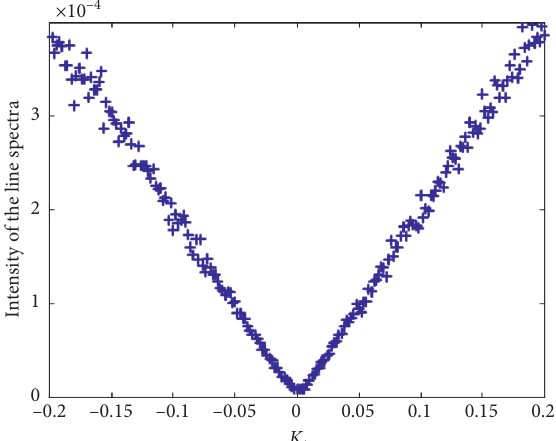
Figure 7: The intensity of the line spectra versus feedback control gain ( σ � 50 , τ � 20 ) .